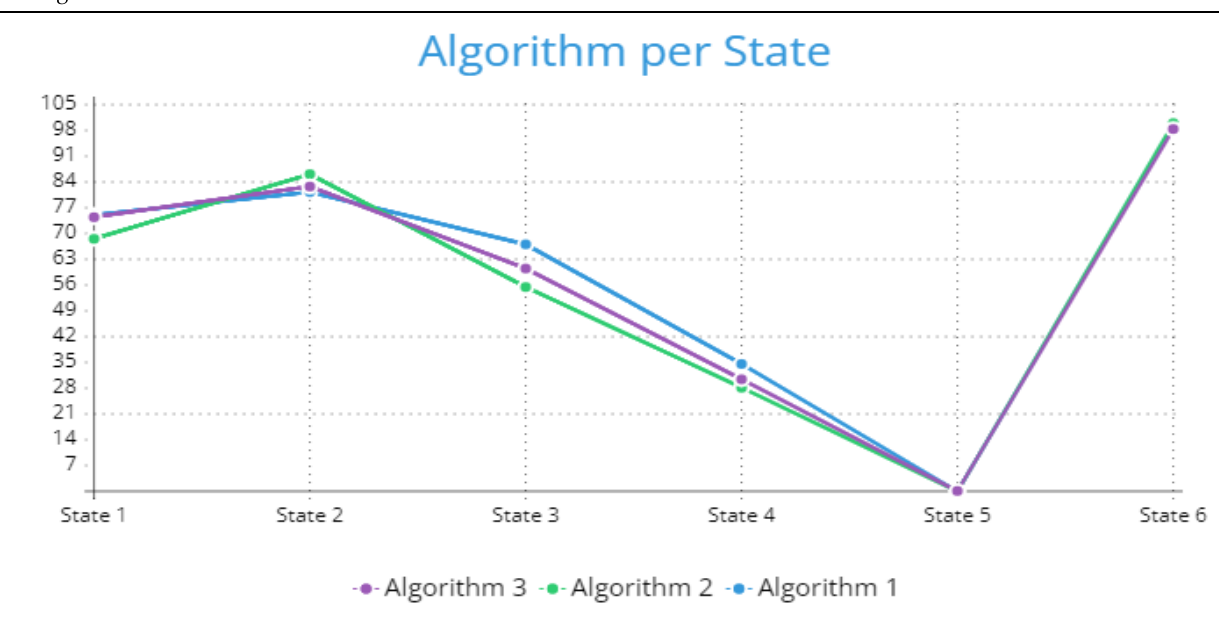
Figure 10. Line Chart for Group Concentration values per Algorithm.